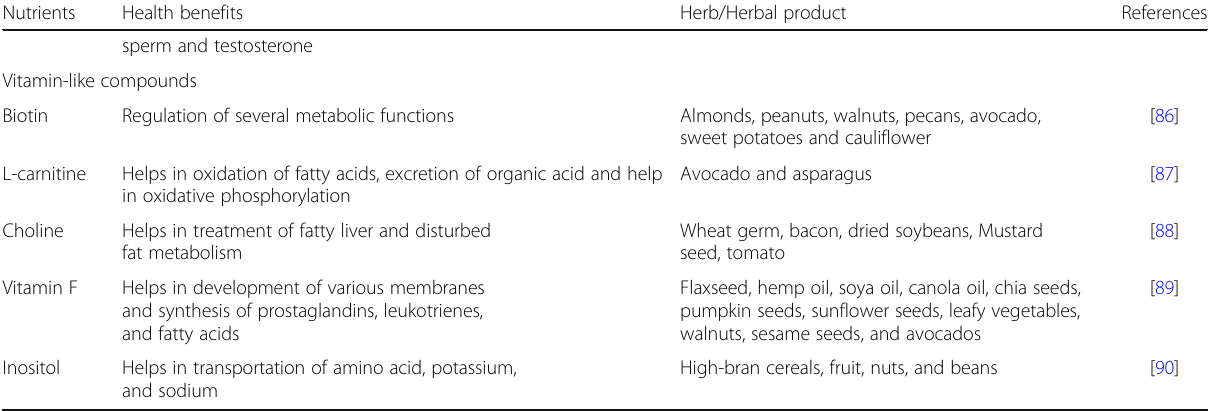
Table 3 Herbal products containing nutrients for different health benefits